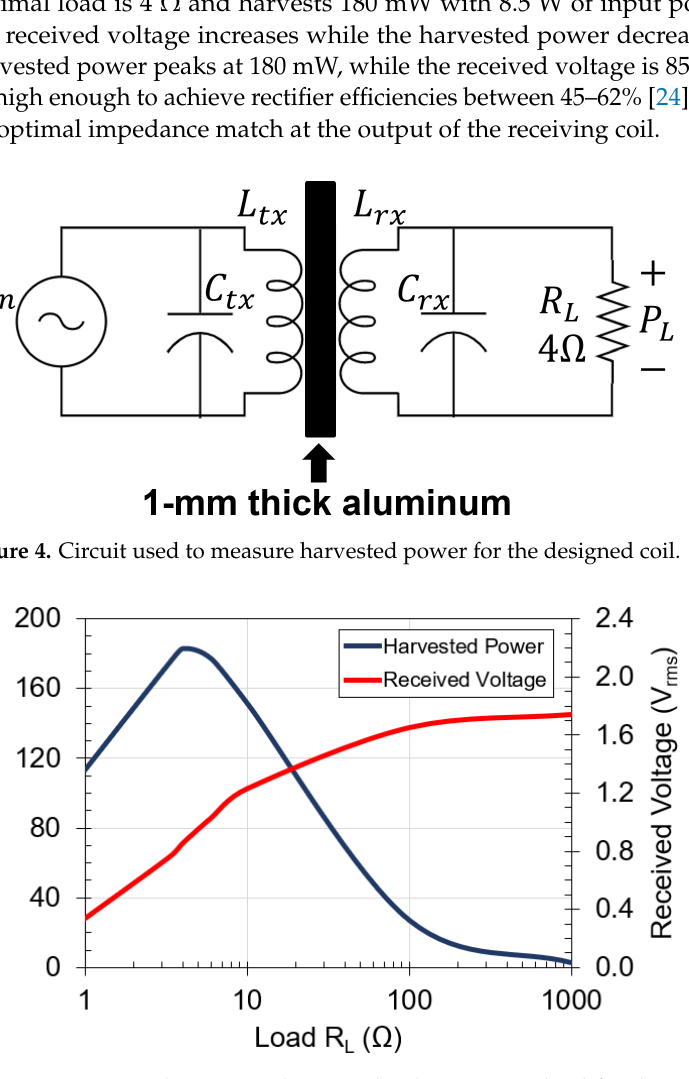
Figure 5. Harvested power and received voltage versus load for designed coil with 1 mm-thick aluminum plate in between. Operating frequency is 2 kHz. Input power is 8.5 W.